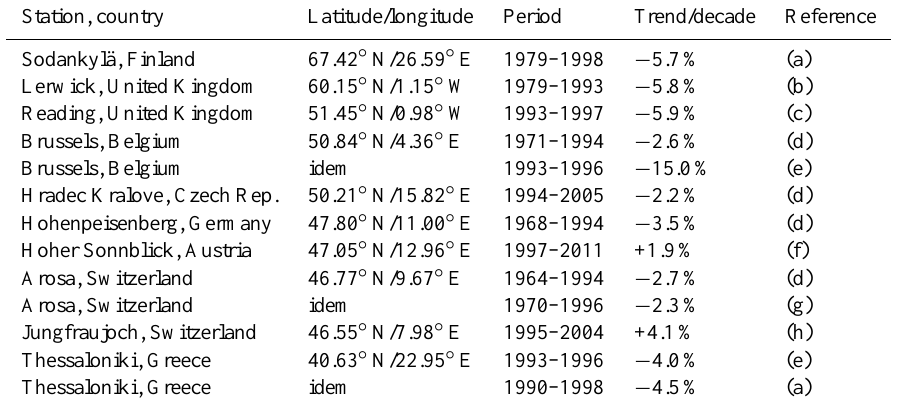
Table 7. Trends of total ozone column at different stations from (a) Glandorf et al. (2005), (b) Smedley et al. (2012), (c) Bartlett and Webb (2000), (d) Bojkov et al. (1995), (e) Zerefos et al. (1997), (f) Fitzka et al. (2012), (g) Staehelin et al. (1998) and (h) Vigouroux et al.